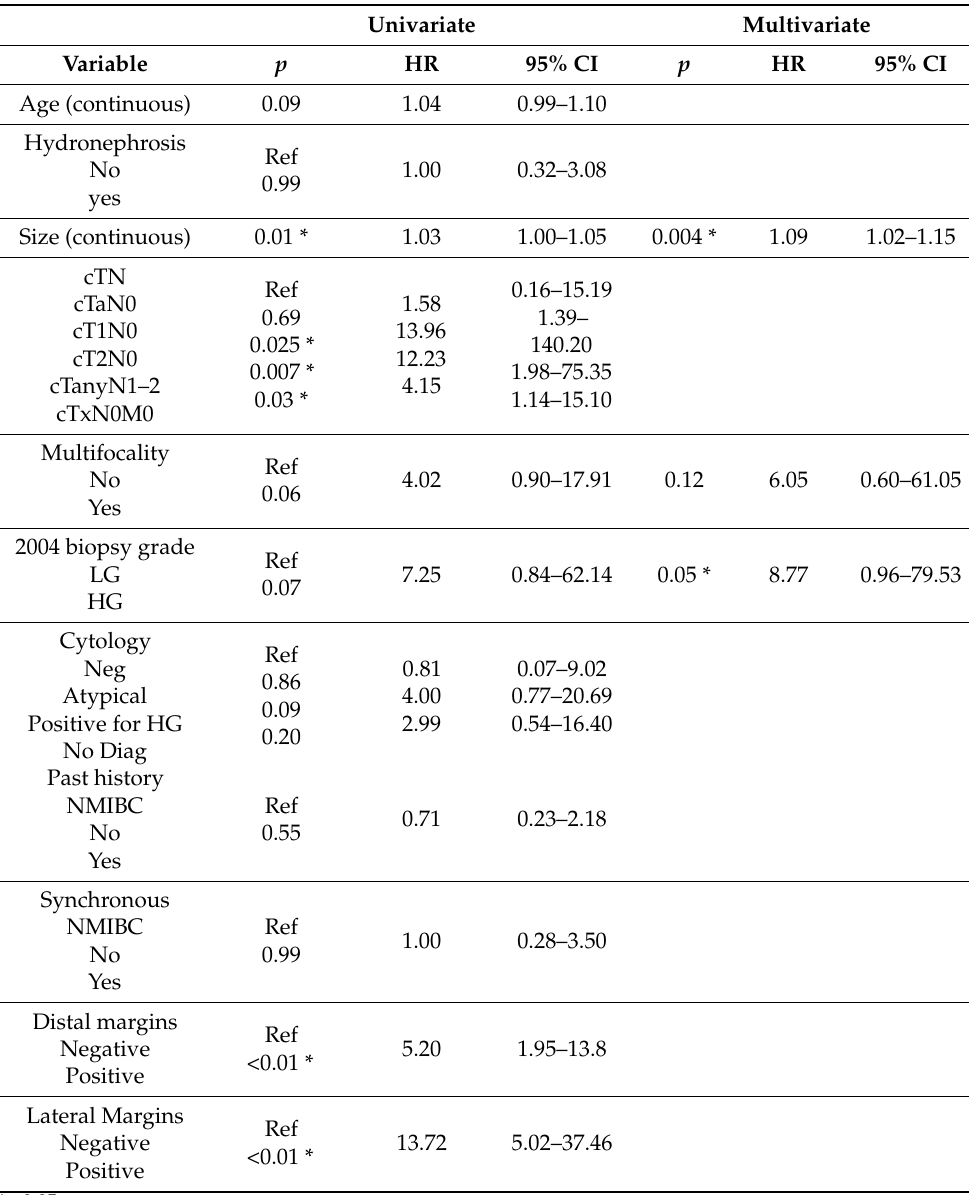
Table 4. Cox regression for factors associated with